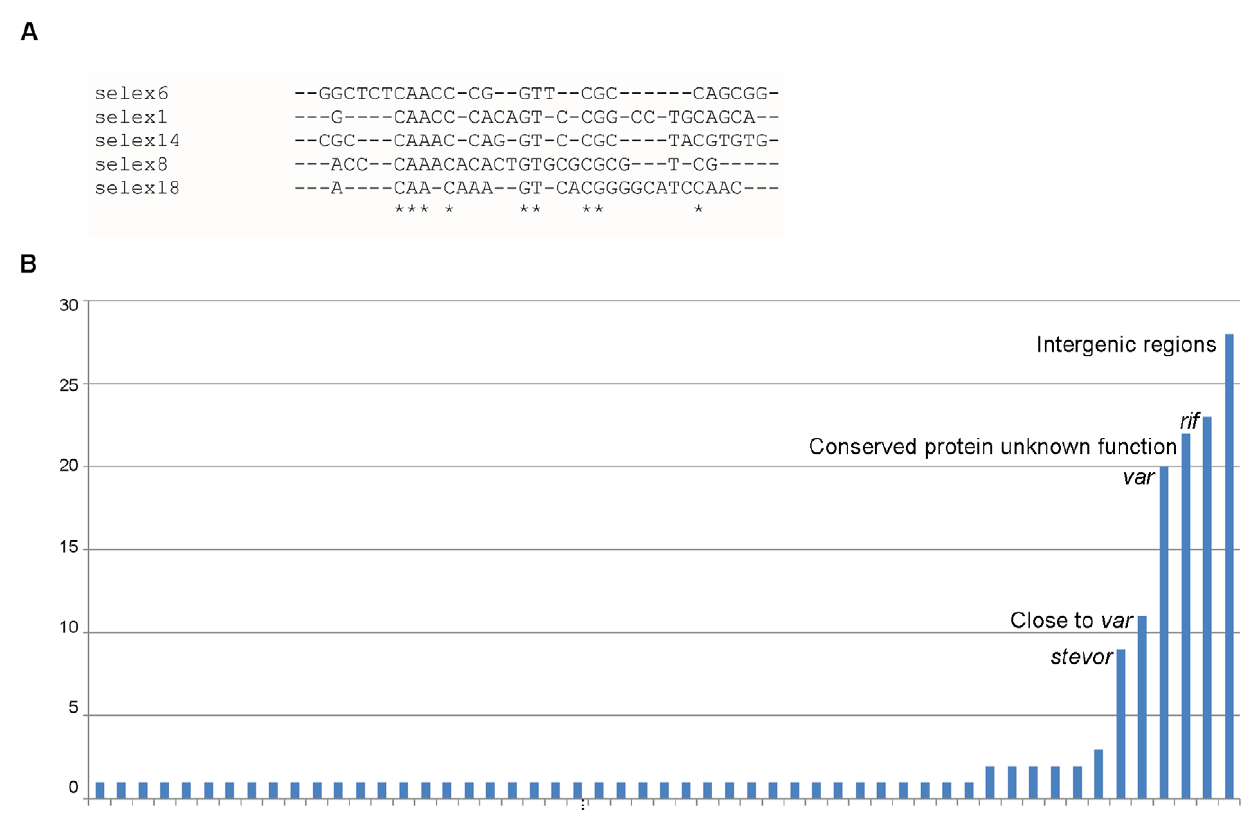
Figure 4. Identified DNA targets of Pf-Int. A ) Clustal sequence alignment of the targets retained by SELEX method showed that the motif: (N)6CAANC(A/C)(N)2GT(N)3CG(N)7C(N)4 seems to be present in all of them. Conserved positions are shown by (*). B ) Distribution of gDNA fragments retained by Pf-Int from genomic DNA capture. Y-axis: number of occurrences. X-axis: identity. Single hits are not labeled, but present in Table S2.